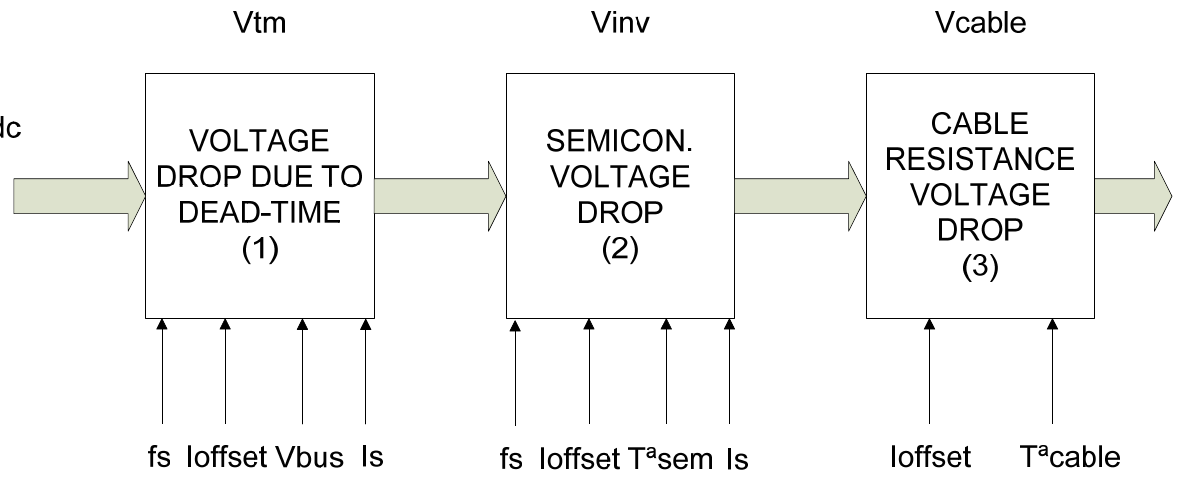
Figure 2. Injected voltage drop representation.